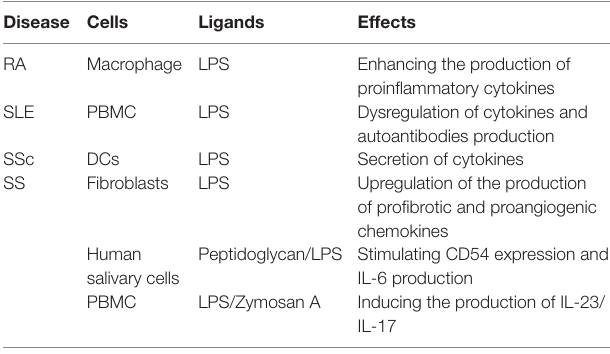
TABLe 3 | effects of ligands of TLR2 or TLR4 on different cells in autoimmune diseases. Disease